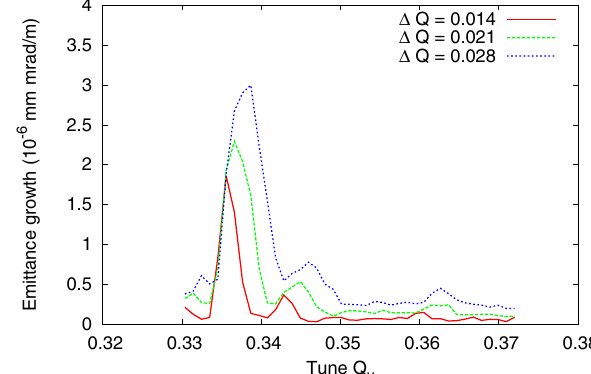
1000 FIG. 12. Emittance growth rate for different vertical tunes Q after N x i k ¼ the vicinity of the third order stochastic resonance, while the ≃ 1 . 001 . The vertical tune Q horizontal tune is Q x systematically in steps of Δ Q ¼ 0 . 001 . The colors represent different beam currents.